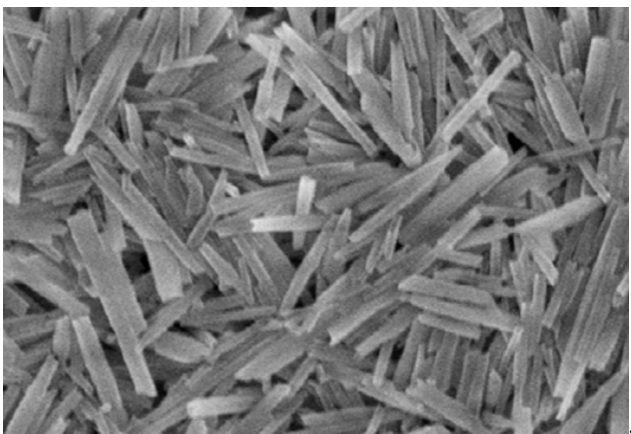
Figure 5. SEM results of the natural HNTs [39].